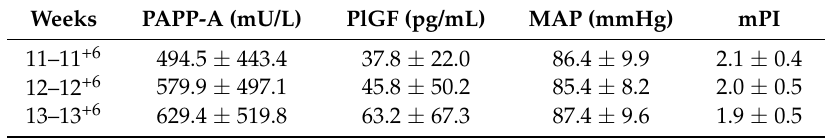
Table 2. Biochemical and biophysical markers in gestational ages (Mean ±